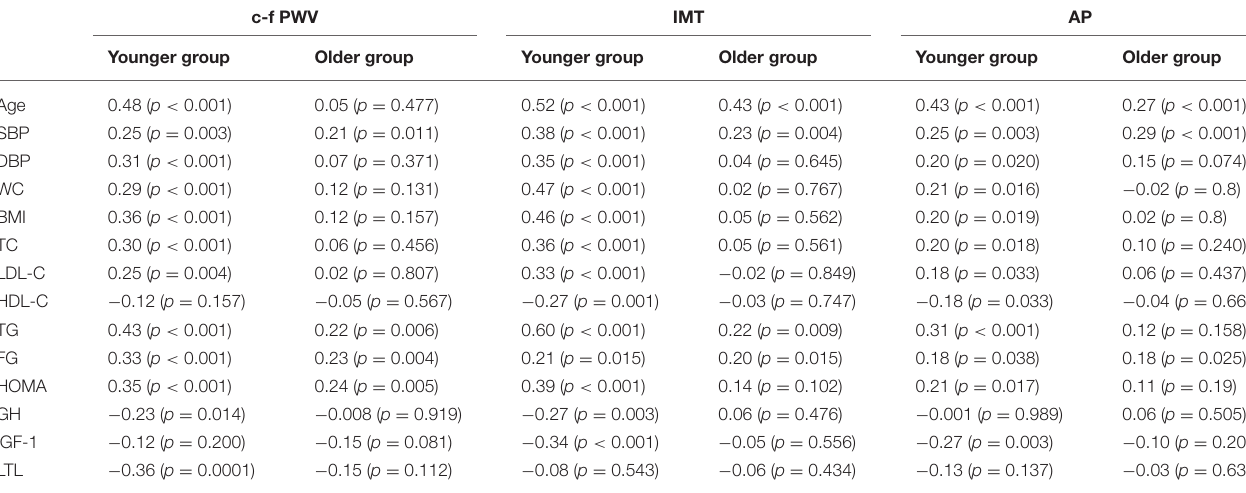
TABLE 4 | Associations between the arterial wall characteristics and studied parameters in different age